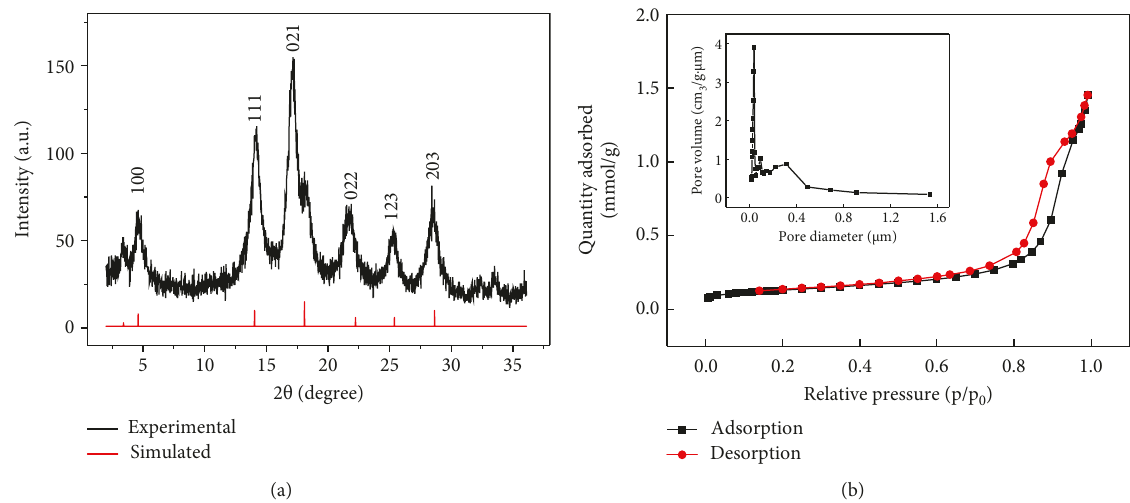
Figure 2: (a) Experimental (black curve) and simulated (red curve) XRD patterns for the as-prepared COF desorption isotherm (BET) for the as-prepared COF TFPB-TZT . The insert shows the pore distribution of COF TFPB-TZT .